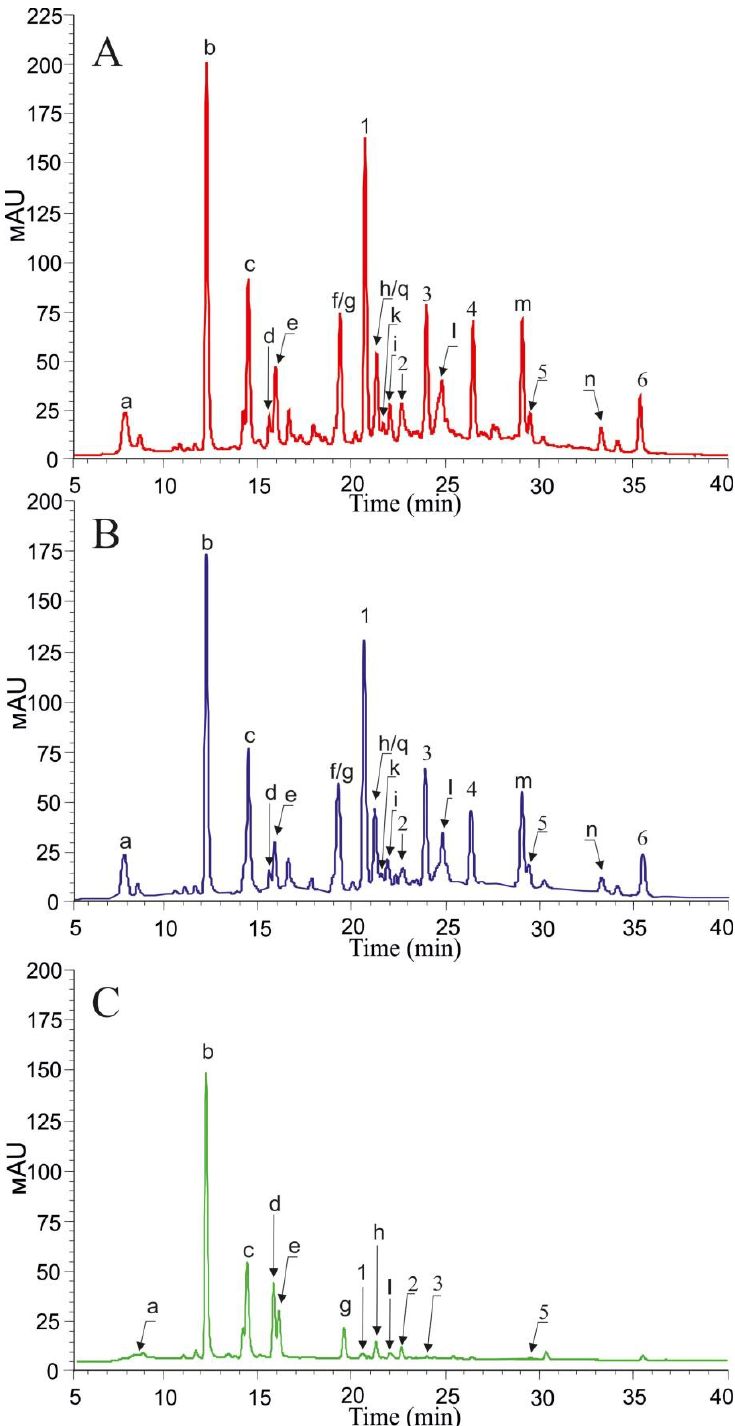
Figure 1. A representative HPLC-UV profile (310 nm) of the extracts from red wine (Fanagoria Merlot, NR collection, vintage 2016), analyzed immediately after opening ( A ) and after six months of storage in the dark at +10 °C ( B ); HPLC-UV profile (310 nm) of the extracts from white wine (Fanagoria Riesling, Fine Select, vintage 2017), analyzed immediately after opening ( C ). Trans -piceid (1), trans -piceatannol (2), cis -piceid (3), trans -resveratrol (4), cis -resveratrol (5), δ -viniferin (6). (a) gallic acid, (b) caftaric acid, (c) coutaric acid, (d) caffeic acid, (e) fertaric acid, (f) myrecitin-3-O-glucoside, (g) p -coumaric acid, (h) hexose ester of protocatechuic acid, (i) dihydroquercetin-3-O-rhamnoside, (q) quercetin-3-O-glucoside, (k) quercetin-3-O-glucuronide, (l) myricetin, (m) quercetin, (n) kaempferol.